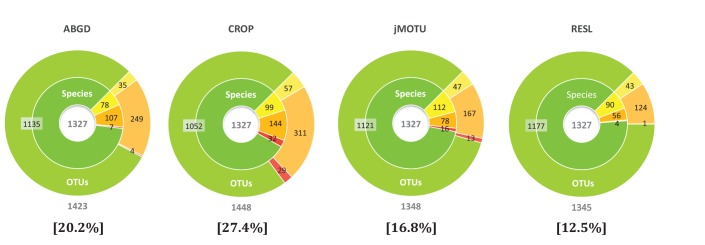
A comparison of the performance of four algorithms in OTU assignments for the Lepidoptera of eastern North America dataset.Each inner ring partitions species, based on their assignment to BINs as MATCHES (green), MERGES (yellow), SPLITS (orange) or MIXTURES (red). Each outer ring categorizes BINs into those that MATCHED species, SPLIT species, MERGED species or MIXTURES using the same colour scheme. The number below each chart is the OTU count while the percentage indicates the incidence of OTUs that were not MATCHES.